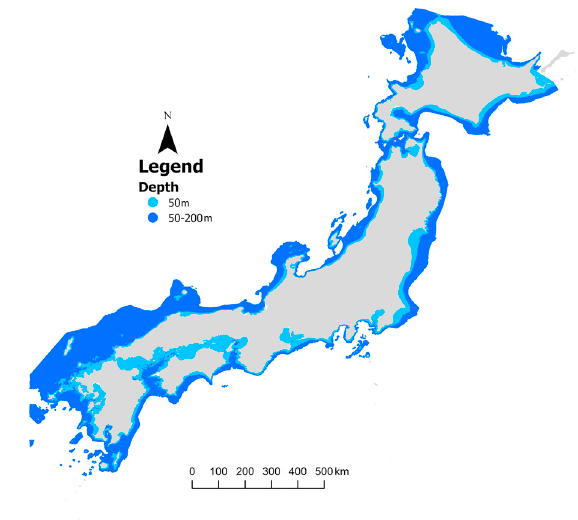
Figure 3. Simplified ocean surface topography of Japan.